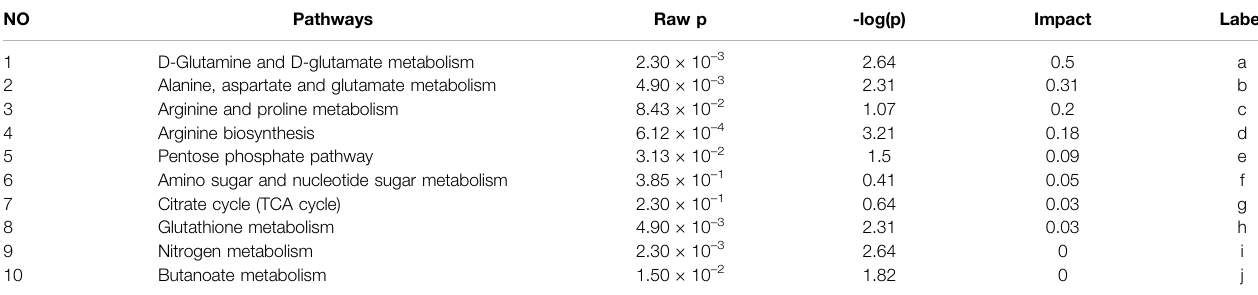
TABLE 2 | Metabolic pathways of QRKSG during the treatment of NS. NO